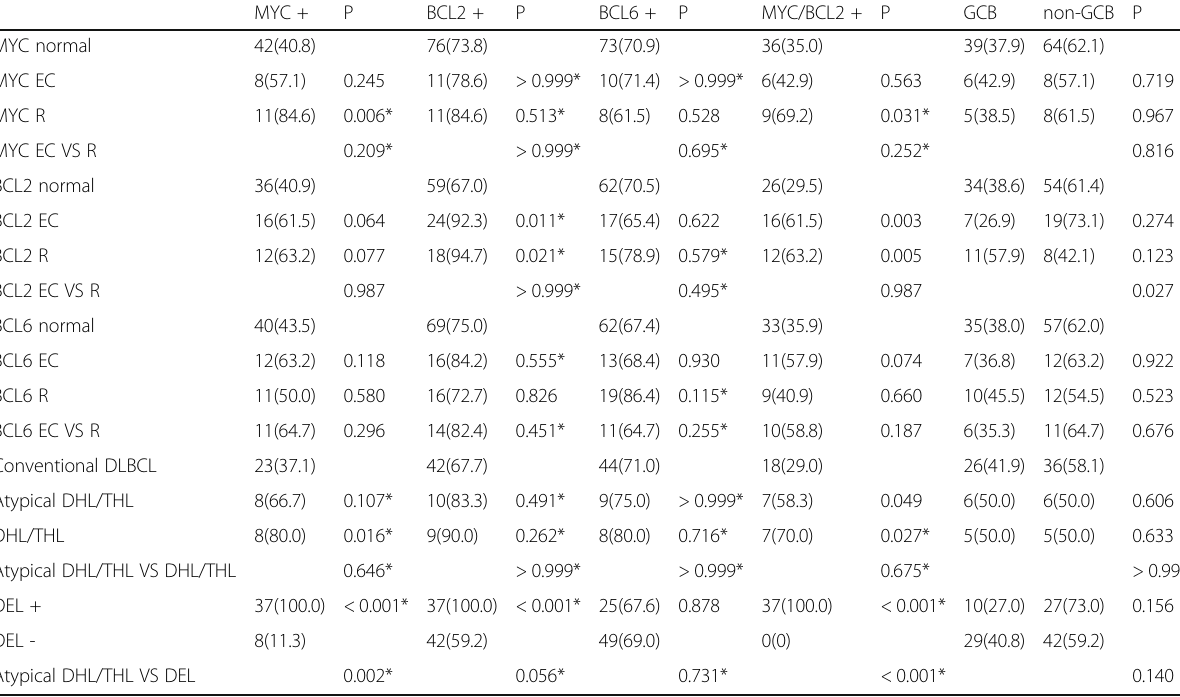
Table 1 The relationship between MYC, BCL2 and BCL6 genetic alterations and protein